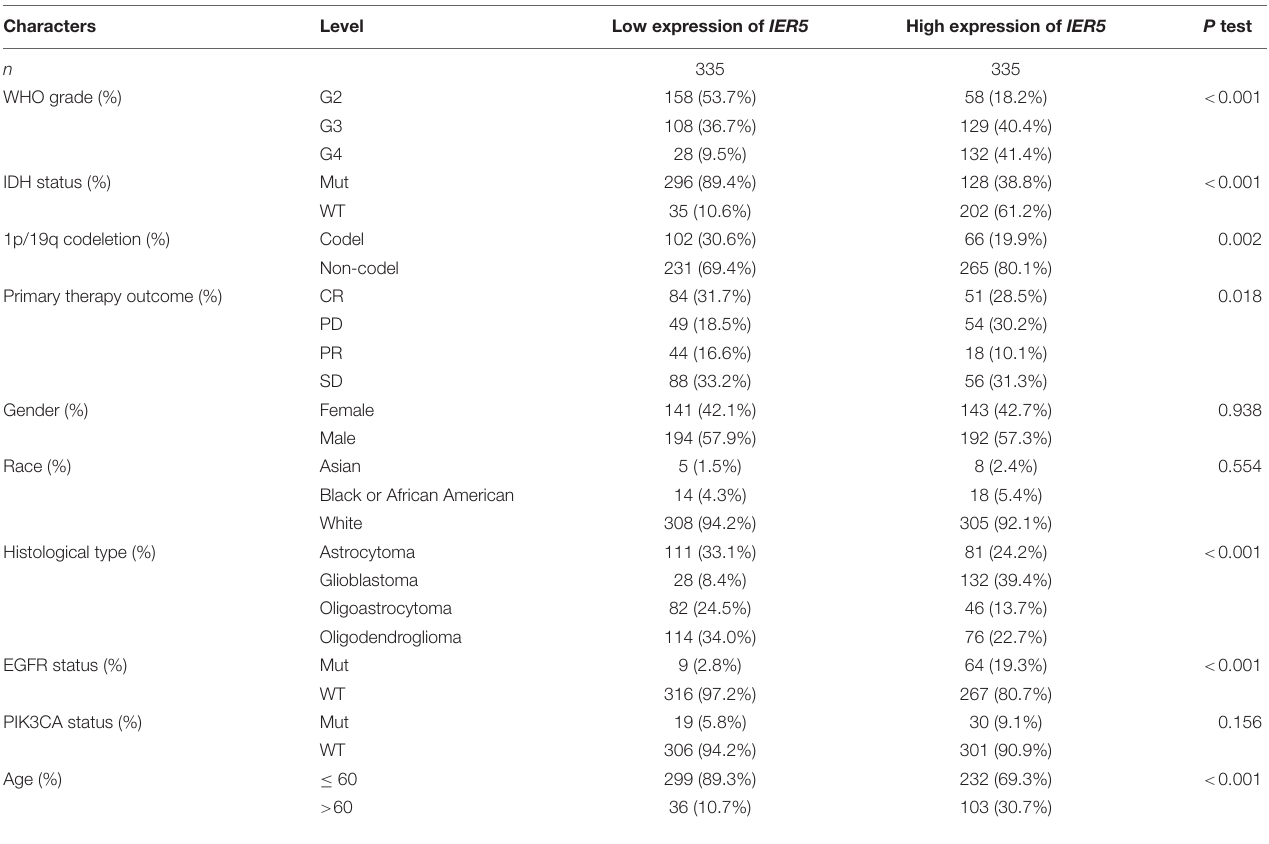
TABLE 1 | Characteristics of patients with glioma based on